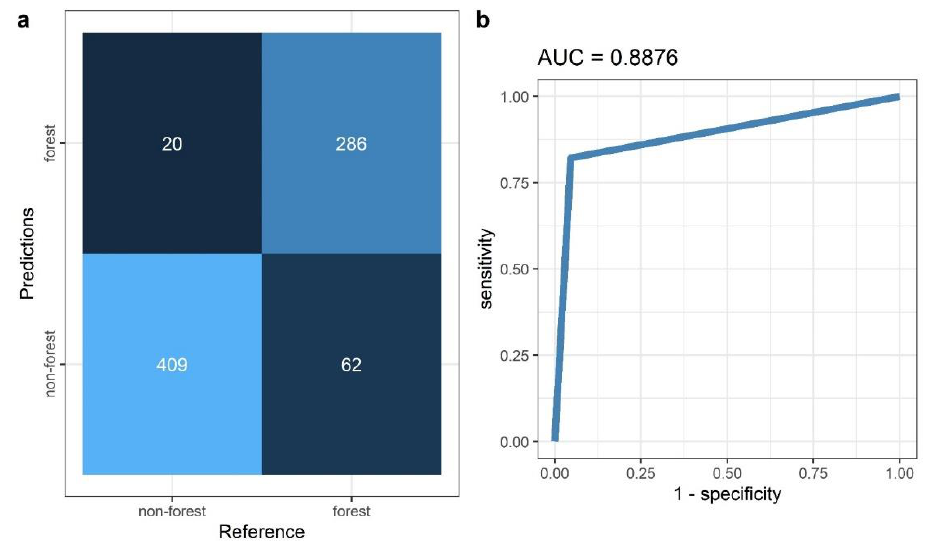
Figure 4. ( a ) A confusion matrix of the binary model validation (for the year 1988) and ( b ) the ROC-AUC graph.